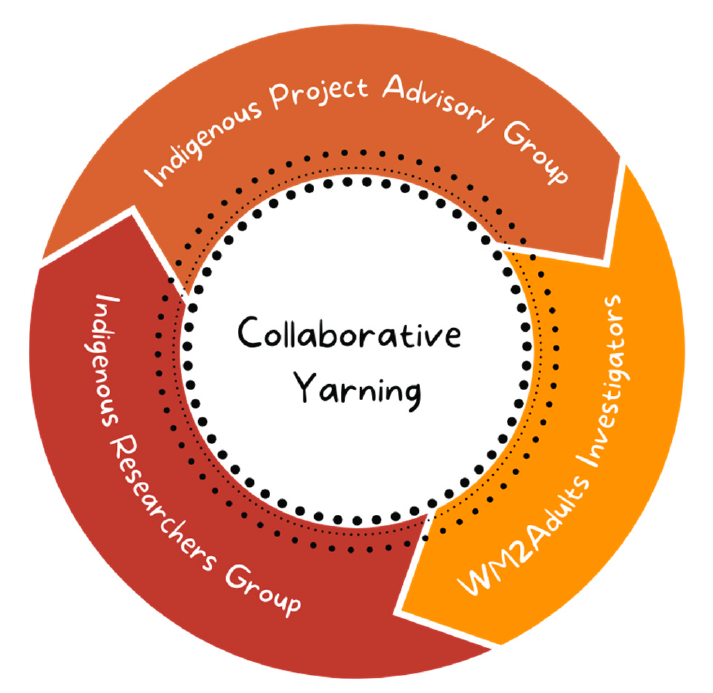
Figure 1. Groups involved in the collaborative yarning process.